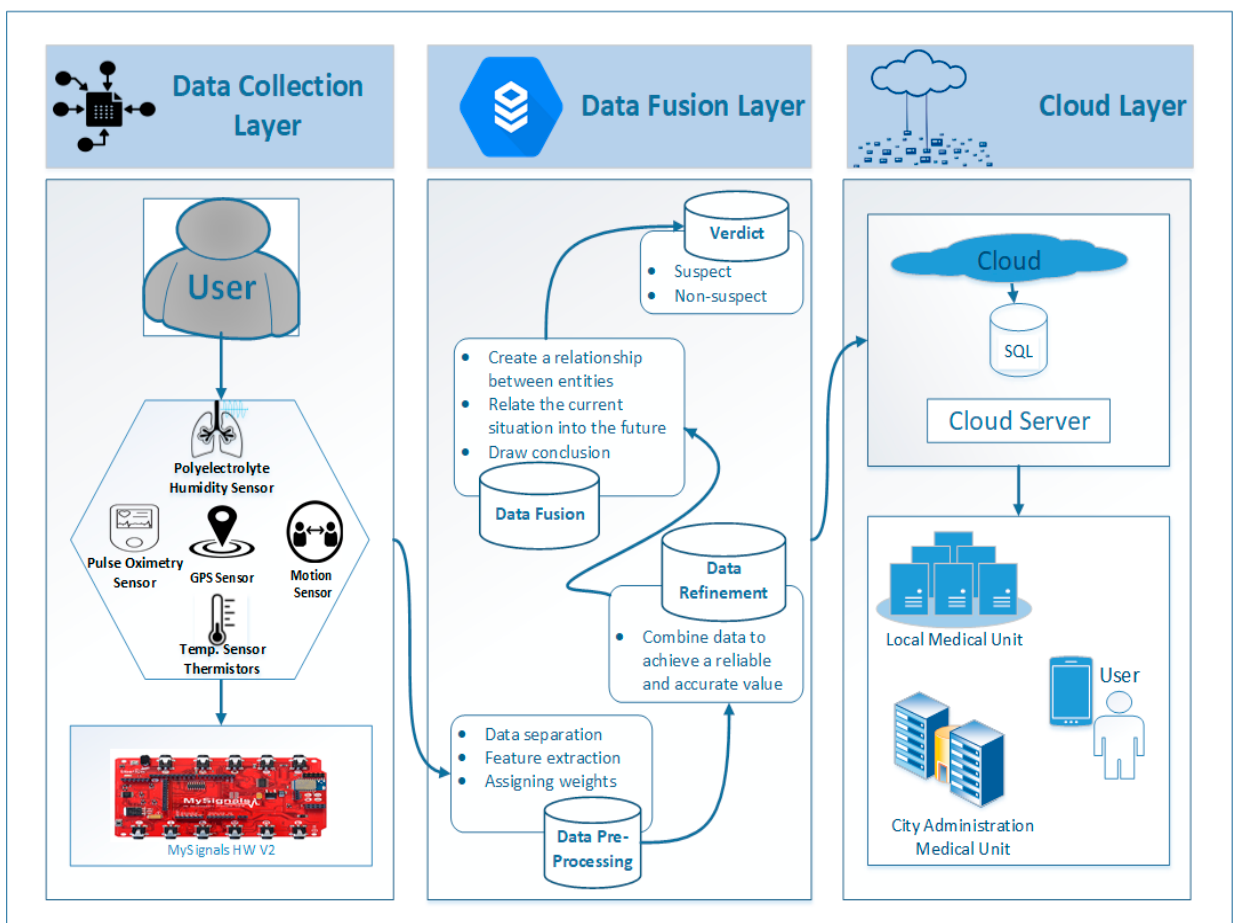
Figure 2. The Proposed Framework: An illustration of Rule-Based Fuzzy Logic classifier for COVID-19 Detection (FLCD) .